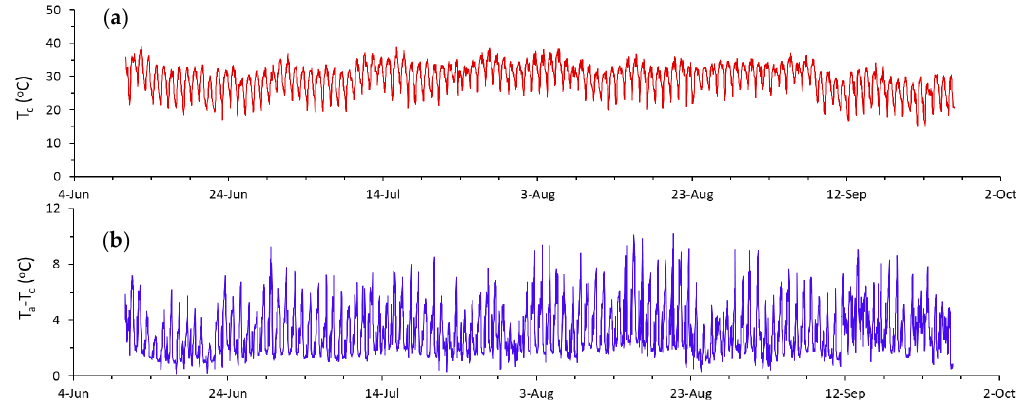
Figure 9. Half-hourly ( a ) canopy temperature and ( b ) differences between above canopy air temperature and canopy temperature at the DP3 experimental site. The average temperature measured by the two infrared thermometers (IRTs) was considered as canopy temperature and air temperature was measured at a height of about 0.8 m above the top of trees.